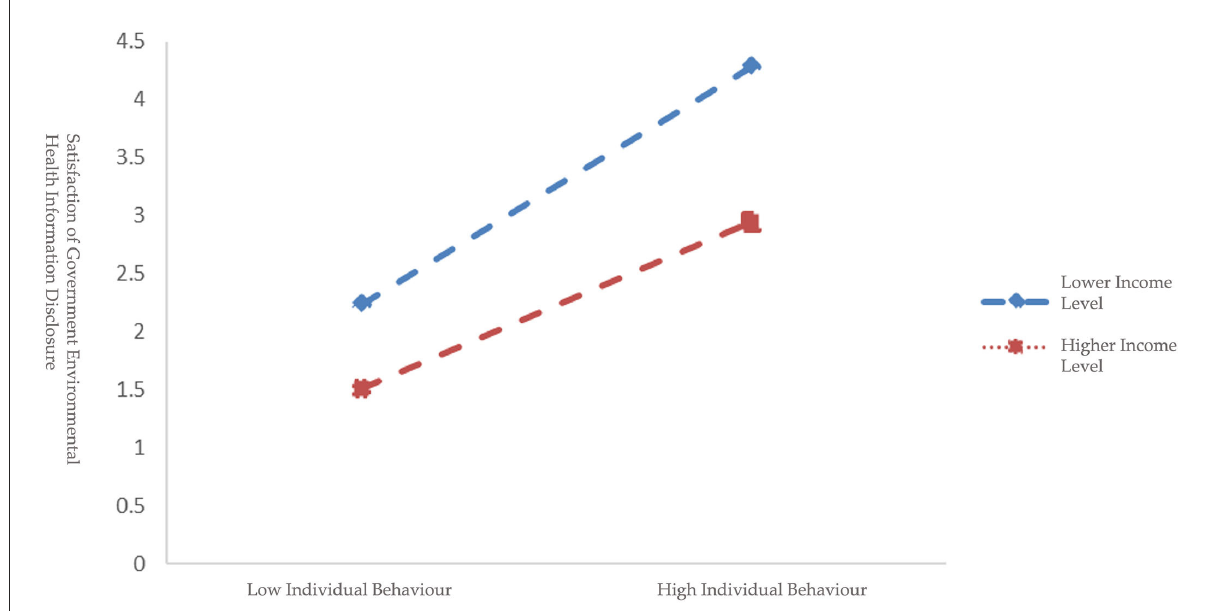
FIGURE4 Moderating effect of income level between environmental behavior and satisfaction of government environmental health information